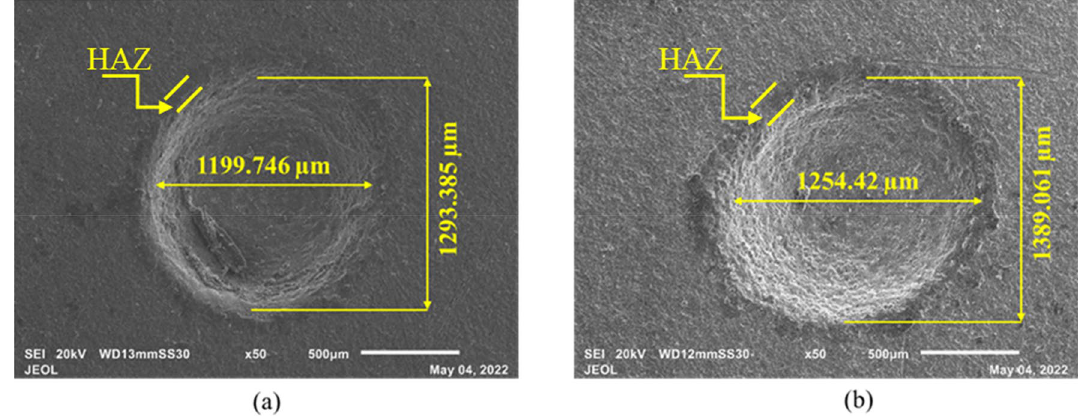
Figure 11. Micrographs of the machined microholes at ( a ) 70 V, 25 wt%, 50% DF and ( b ) 70 V, 25 wt%, 70% DF.